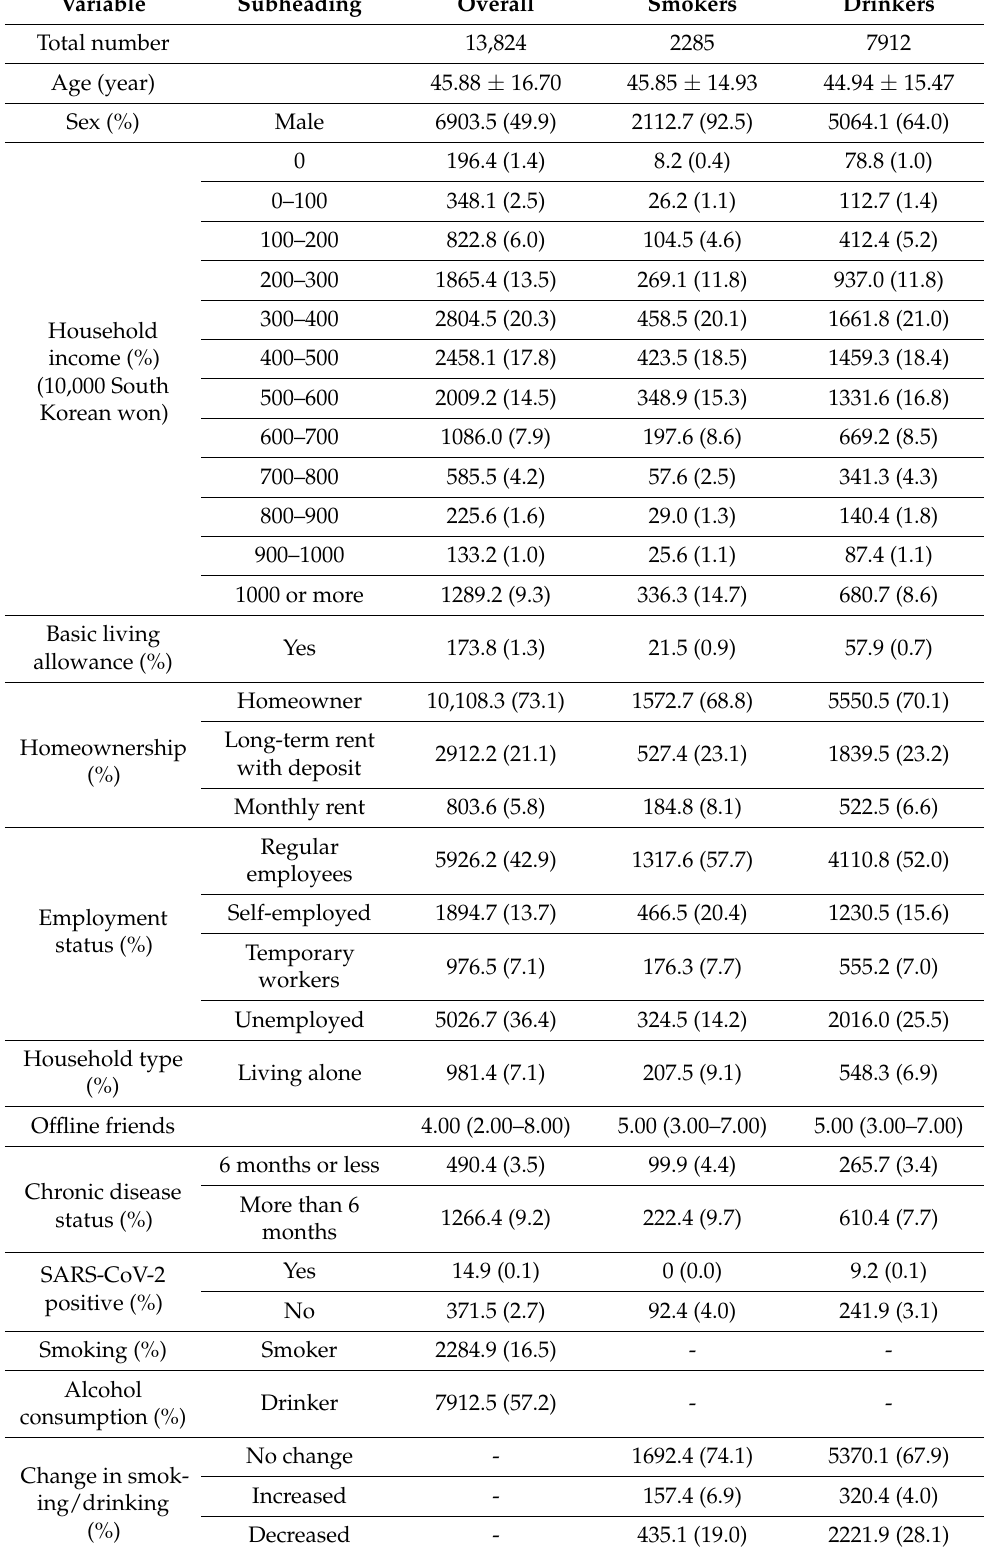
Table 1. Characteristics of the nationally representative sample in South